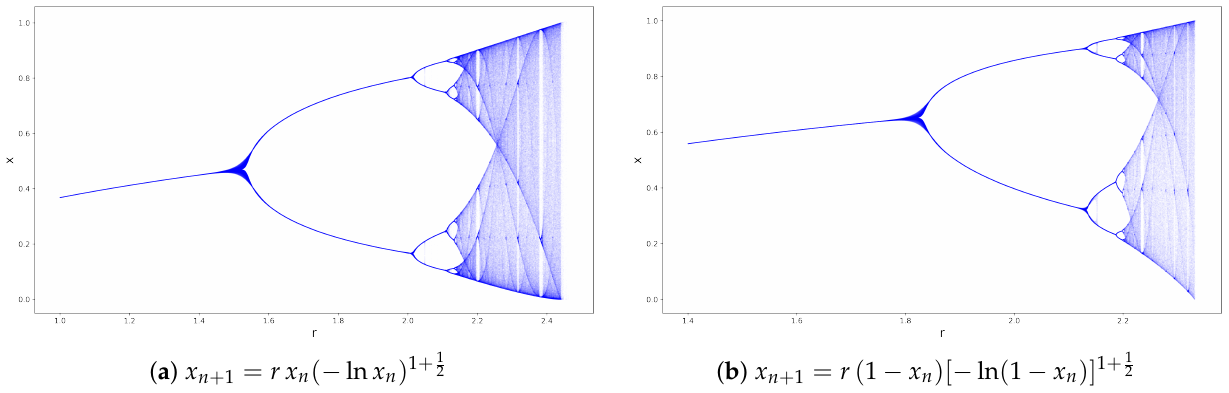
Figure 14. Bifurcation diagrams for the Turner map x n + 1 = r x n ( − ln x n ) 1 + 1 2 (Fréchet-2, see Figure S2 in Supplementary materials) and for the modified Turner map x n + 1 = r ( 1 − x n )[ − ln ( 1 − x n )] 1 + 1 2